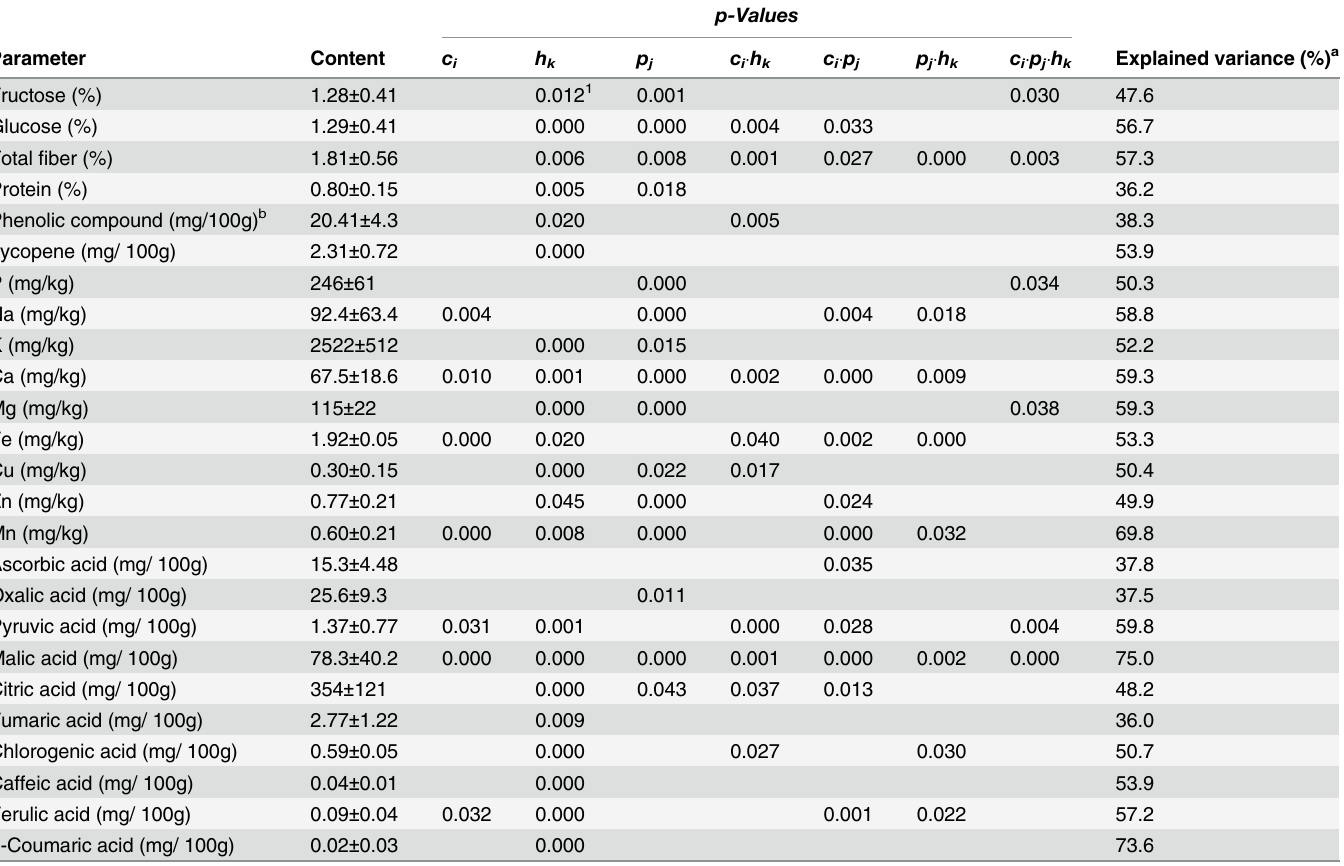
Table 1. Mean content of the chemical parameters and estimation of the influence factors ( p -value). Data are expressed as % or quantities per fresh weight.